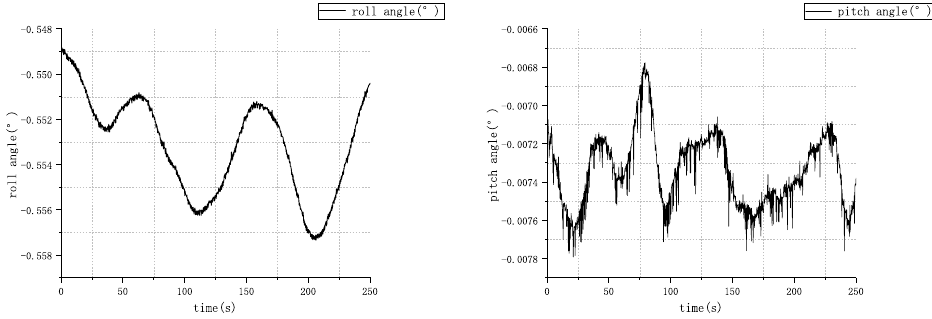
Figure 7. Dataset 2: The raw roll and pitch angle of the ship.